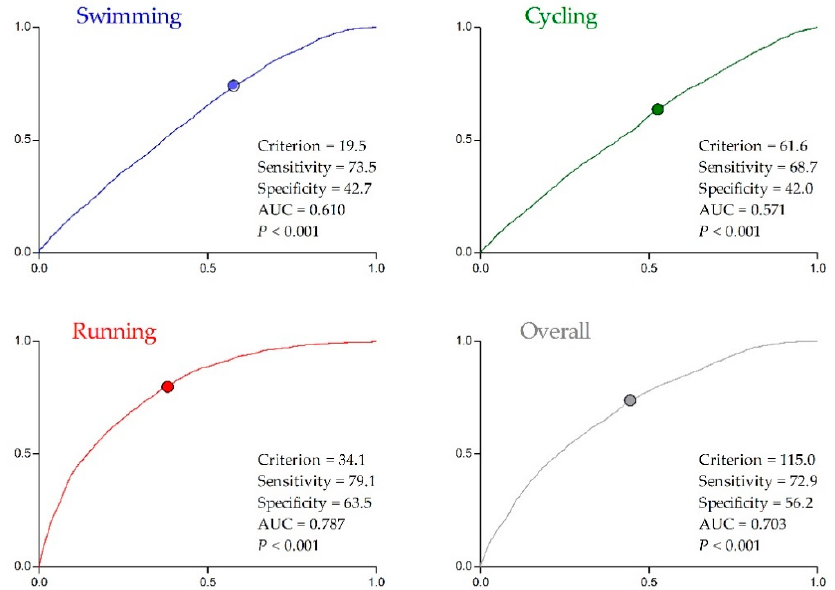
Figure 3. Receiver operating characteristic curve (sensitivity: y -axis; specificity: x -axis) according to the top three male rank position of each trait of triathlon (Draft period: 2000–2019): AUC = area under the curve.